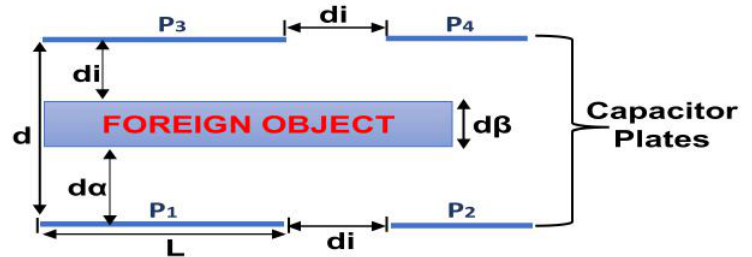
Figure 13. A dielectric foreign object in a two-module CPT system.